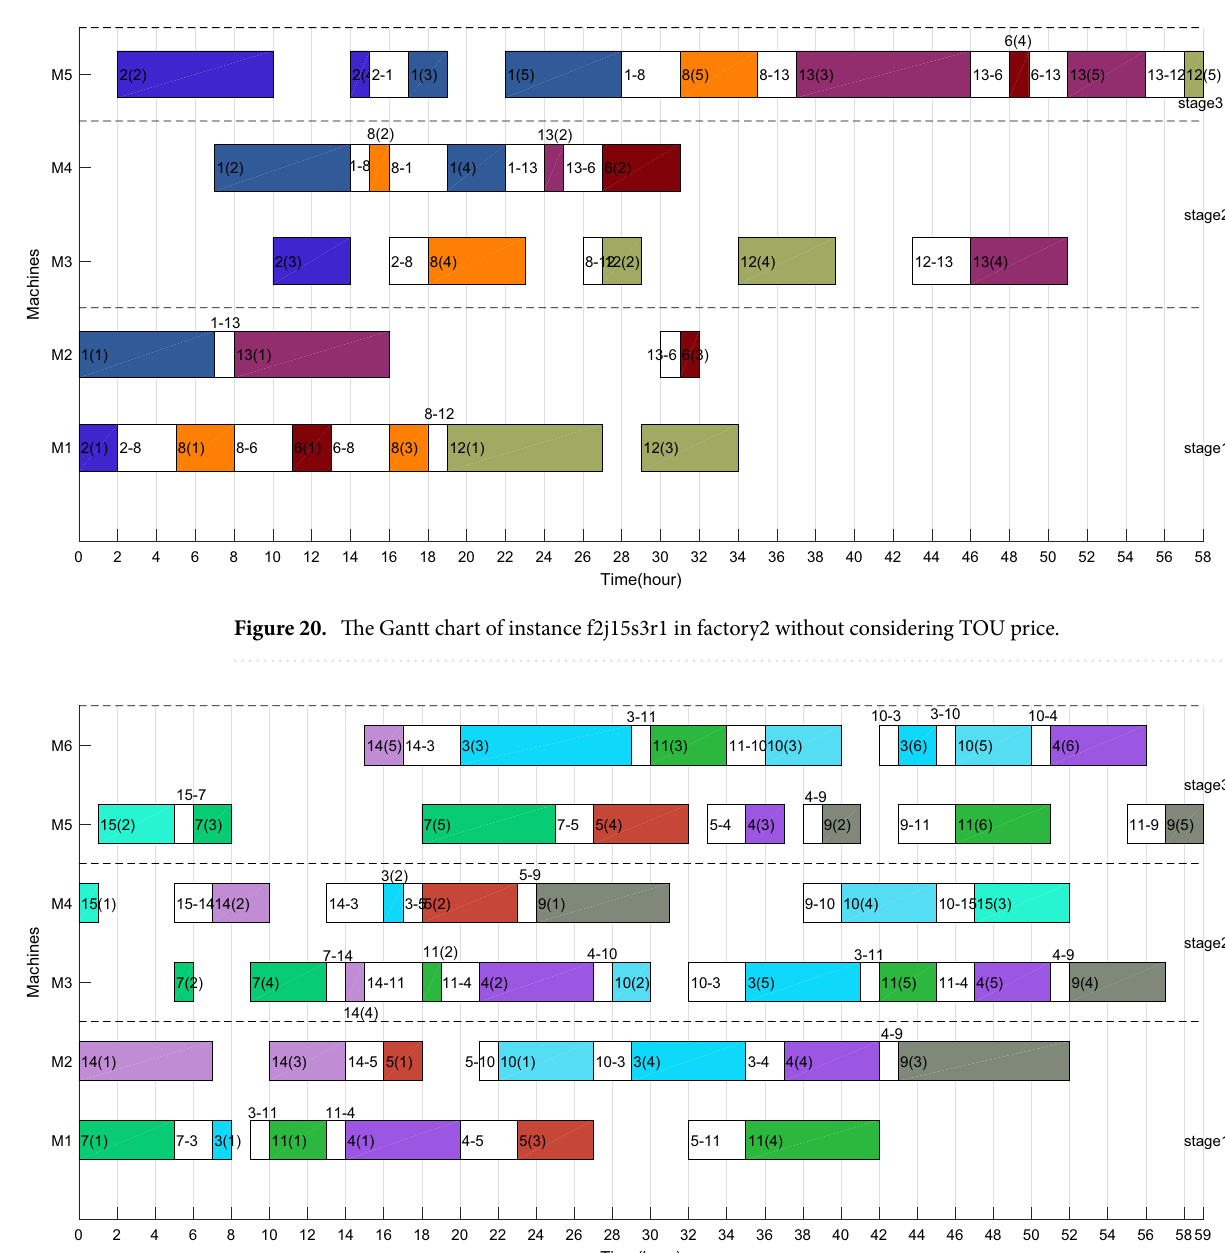
Figure 21. The Gantt chart of instance f2j15s3r1 in factory1 considering TOU